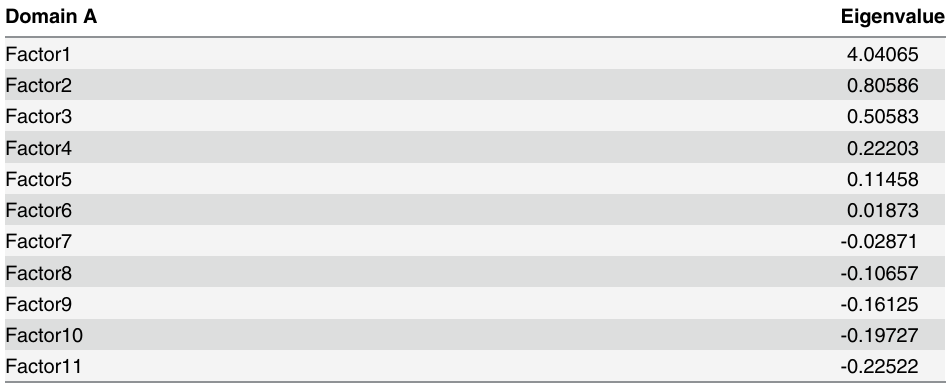
Table 2. Eigenvalues of the domain A in the Osteoporosis Prevention and Awareness Tool (OPAAT) using exploratory factor analysis (EFA).